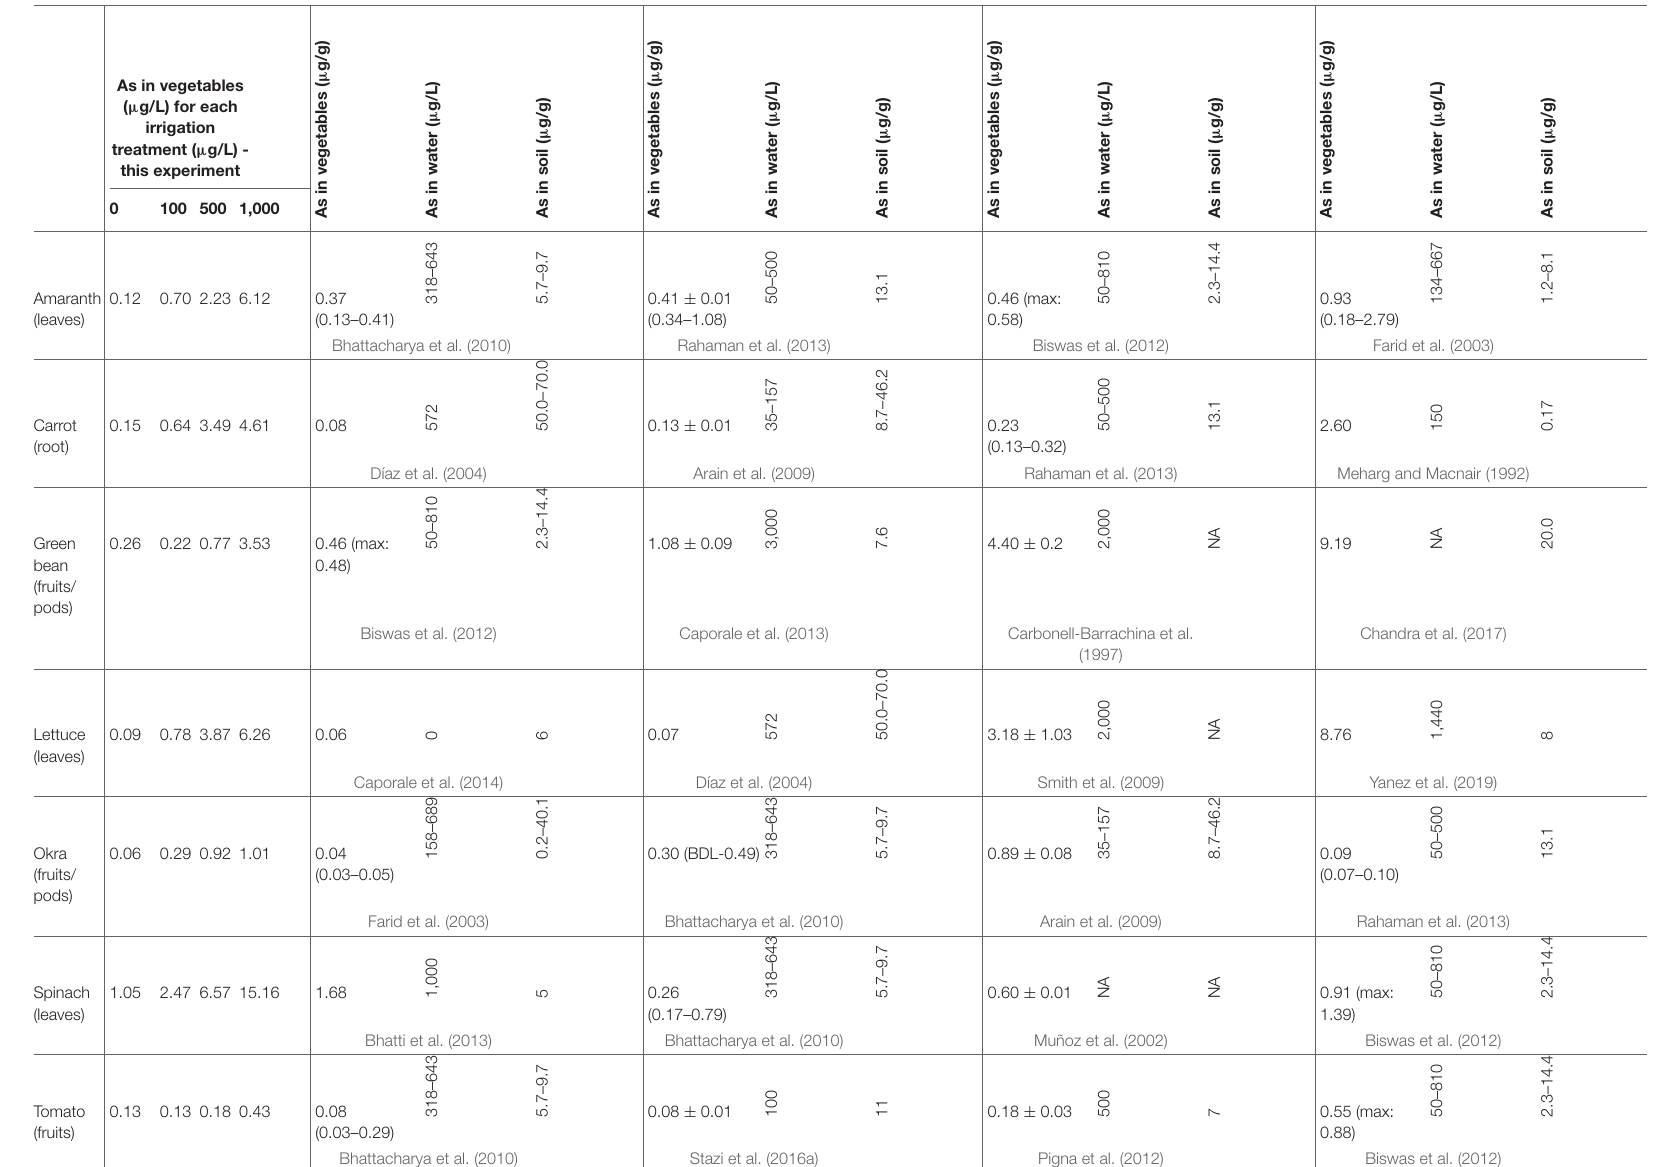
TABLE 5 | Comparison of the As content in the vegetables of this experiment to literature